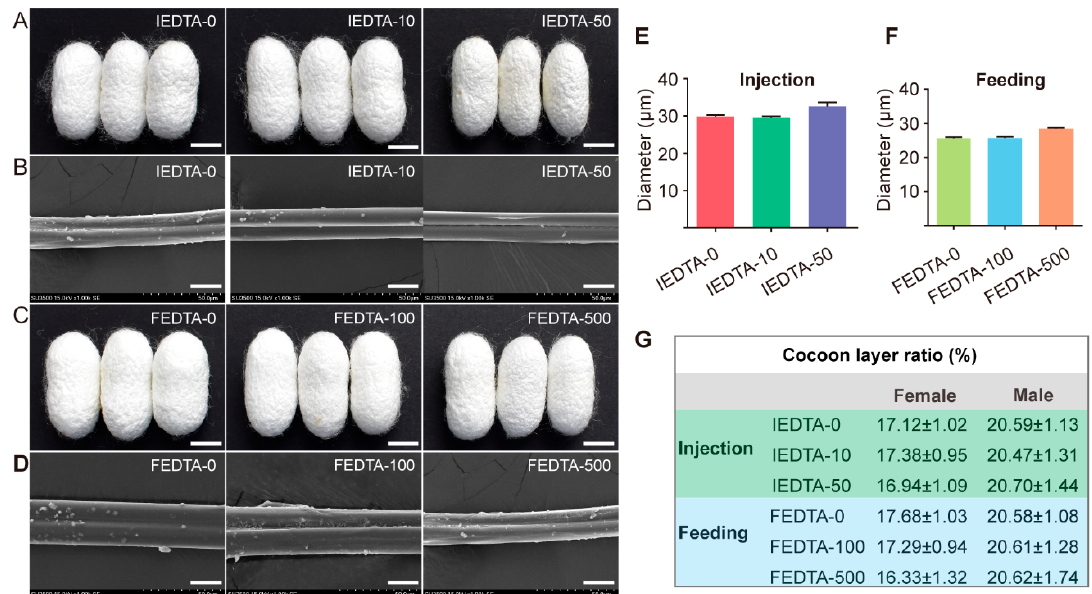
Figure 1. Visual appearance of cocoons and silk fiber after EDTA injection and feeding. ( A , C ), cocoon shapes after EDTA injection and feeding, scale bar is 1 cm. ( B , D ), SEM image of IEDTA and FEDTA silk fiber, scale bar is 20 µ m. ( E , F ), average diameter of silk fiber after EDTA treatment. ( G ) Cocoon layer ration of silkworms after EDTA injection and feeding. IEDTA-0: Injecting 0 mM EDTA to silkworms, IEDTA-10: Injecting 10 mM EDTA to silkworms, IEDTA-50: Injecting 50 mM EDTA to silkworms; FEDTA-0: Feeding 0 mM EDTA to silkworms, FEDTA-100: Feeding 100 mM EDTA to silkworms, FEDTA-500: Feeding 500 mM EDTA to silkworms.